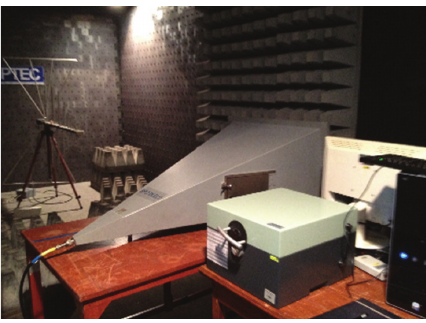
Figure 7: Under EMC test (IEC